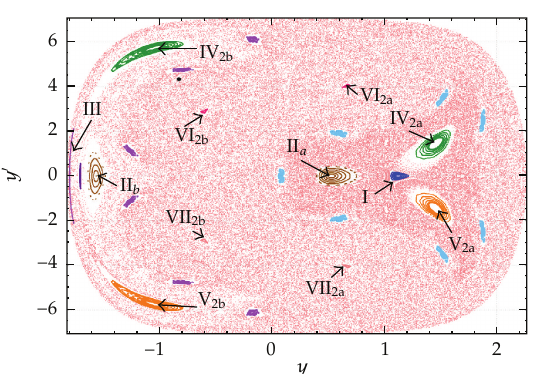
Figure 10: Poincar´e surface of section at E (cid:7) 18 (cid:5) in sixth-order Hamiltonian (cid:6) .